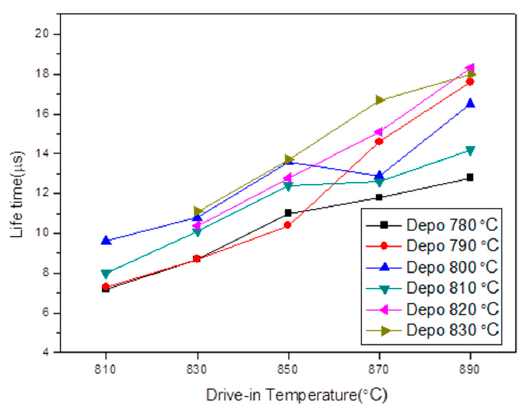
Figure 2. Lifetime of the emitter layer in relation to the temperature difference between the pre-deposition and diffusion processes.